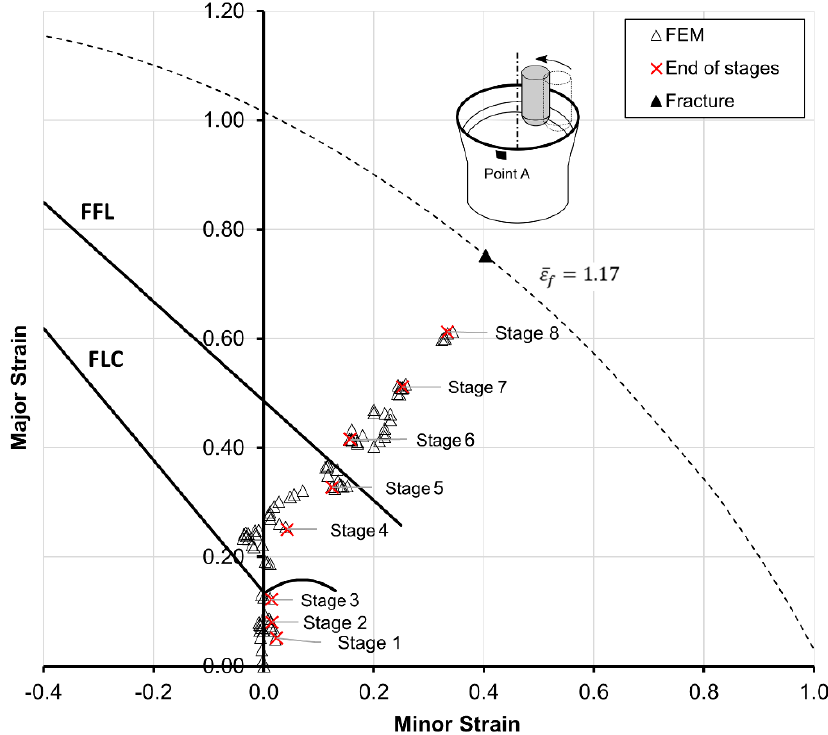
Figure 10. Finite element predicted in-plane strains of point A during the eight forming stages of incremental tube expansion. incremental tube